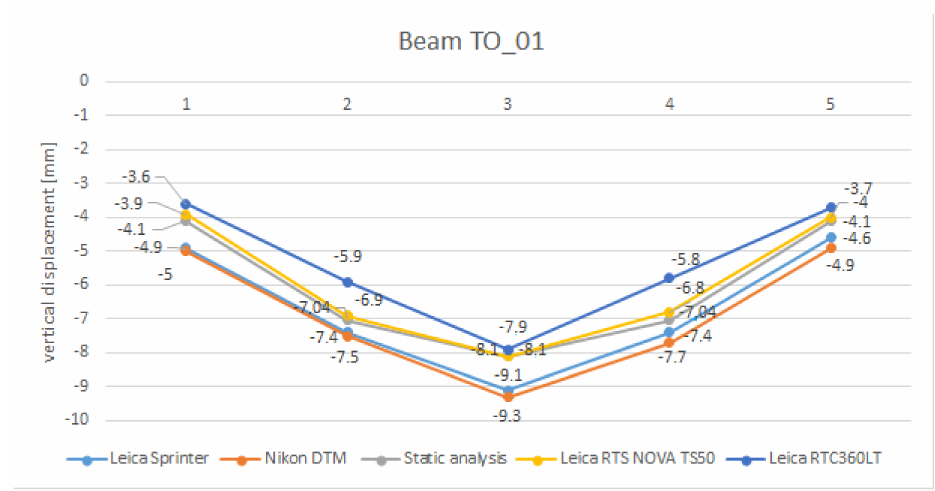
Figure 10. Comparison of the results of the vertical displacements of the beam TO_01.